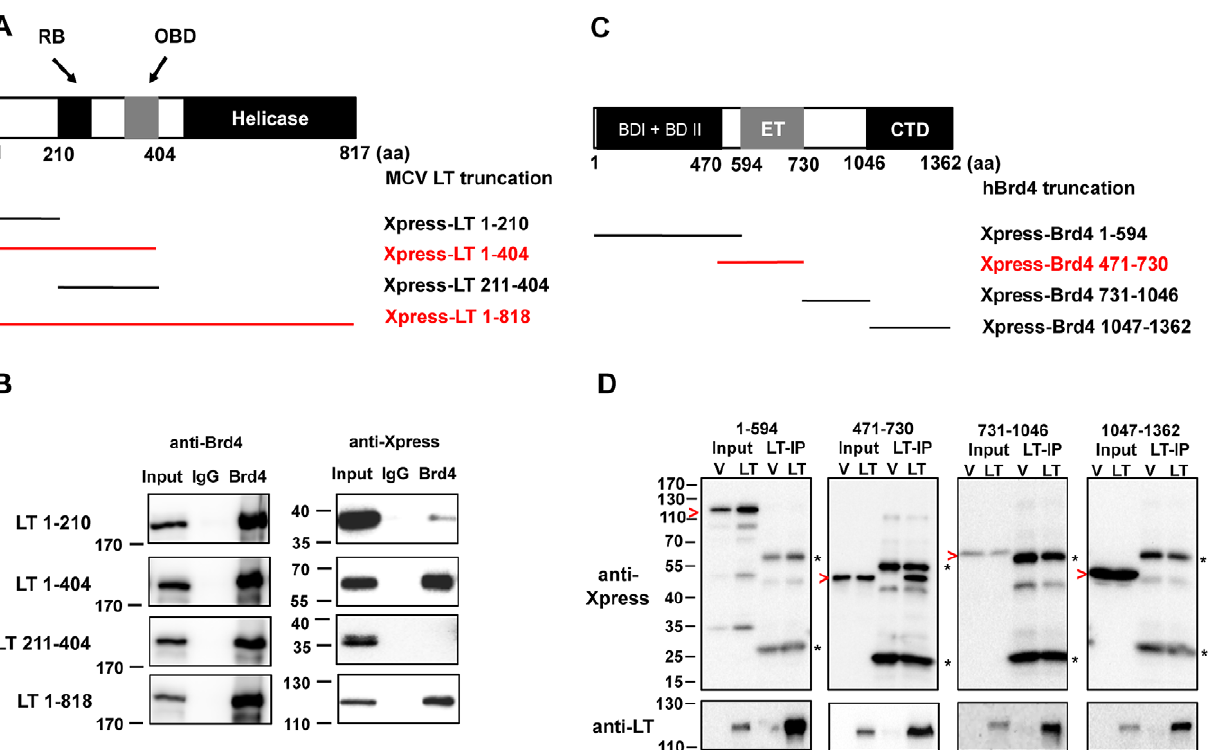
Figure 3. Mapping of the MCV LT and Brd4 interaction sites. A . Schematic diagrams of full-length MCV LT protein and truncation mutants used for mapping. All MCV LT fragments were expressed from a pcDNA4C plasmid encoding an Xpress epitope tag. B . Mapping the Brd4 binding site on MCV LT. 293T cells were transfected with full-length MCV LT or a truncation mutant construct. Nuclear extracts Co-IPed with normal rabbit IgG (IgG) or a Brd4 antibody (Brd4) were immunoblotted with Xpress (LT) or Brd4 antibodies. C . Schematic diagrams of full-length human Brd4 protein and truncation mutants used for mapping. All Brd4 fragments were expressed from a pcDNA4C plasmid as Xpress tagged proteins. D . Mapping the MCV LT binding site on Brd4. 293T cells were co-transfected with a Brd4 mutant construct and either the FLAG-tagged pOZN vector (V) or pOZN-MCV LT (LT). Nuclear extracts IPed with anti-FLAG beads were immunoblotted with Xpress (Brd4) or LT antibodies. Arrowheads mark the positions of the Xpress tagged Brd4 mutants. Asterisks to the right of the blots mark the positions of IP antibody heavy and light chains. For all IPs, 20 m g nuclear protein input and 20% of Co-IPed samples were analyzed.